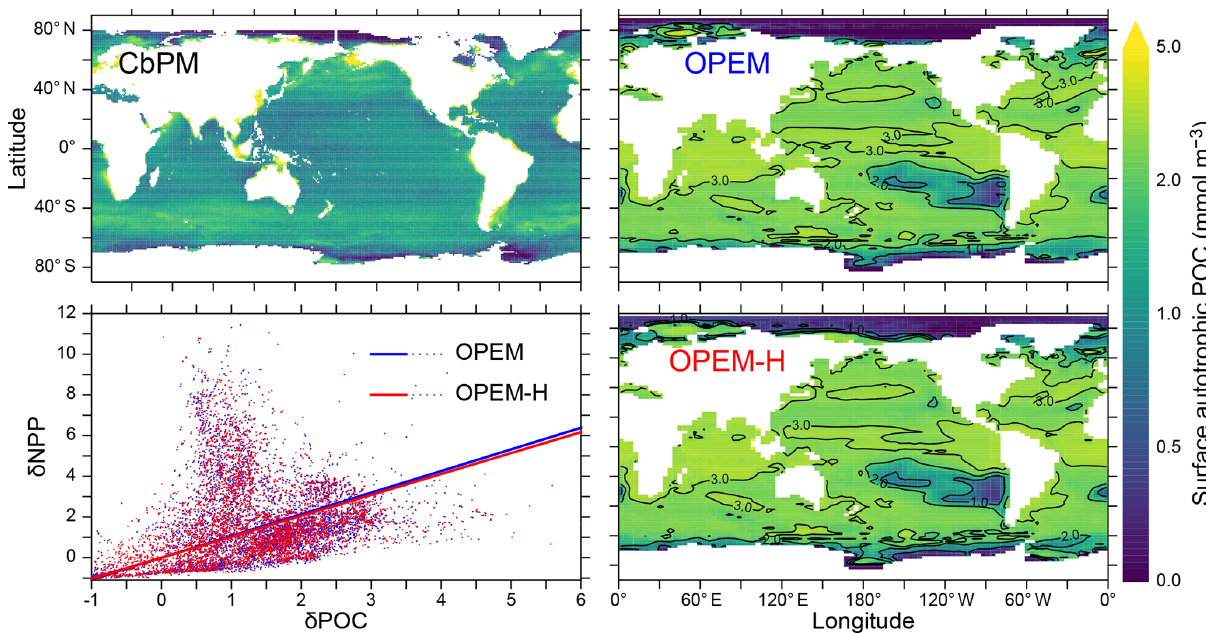
Figure 11. Annually averaged distribution of surface autotrophic POC estimated from satellite data via the CbPM and predicted from the OPEM and OPEM-H UVic simulations. The contours in the right panels indicate multiples of the zooplankton feeding threshold ( (cid:53) th , Eq. C18); i.e. a value of 1 means that effective autotrophic POC (defined as φ phy C phy + φ dia C dia ) is equal to (cid:53) th . The lower left panel illustrates the relation between relative errors in vertically integrated NPP and surface autotrophic POC ( δ NPP and δ POC, respectively) with respect to the CbPM data. The relative errors δx are defined as δx = x model /x CbPM − 1. The solid lines show the regressions forced through the origin. The slopes of these lines are 1 . 064 ± 0 . 059 ( R 2 = 0 . 05, OPEM) and 1 . 028 ± 0 . 024 ( R 2 = 0 . 25, OPEM-H). The satellite-based CbPM estimate is the average for 1998–2007 (Westberry et al., 2008) with missing data treated as